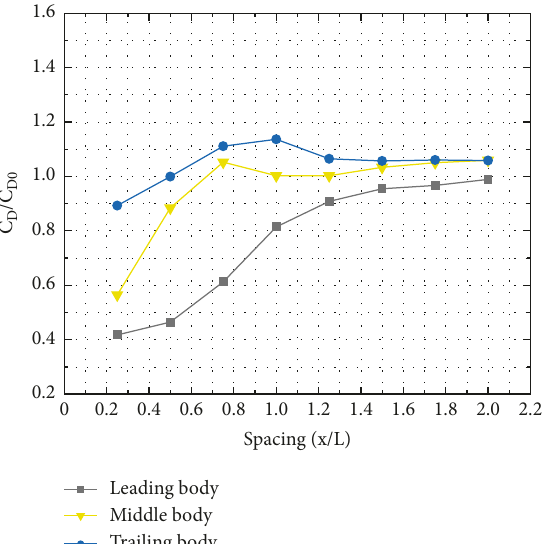
Figure 13: Normalized drag coefficient C D /C D0 of three Ahmed bodies under different inter-vehicle distances.